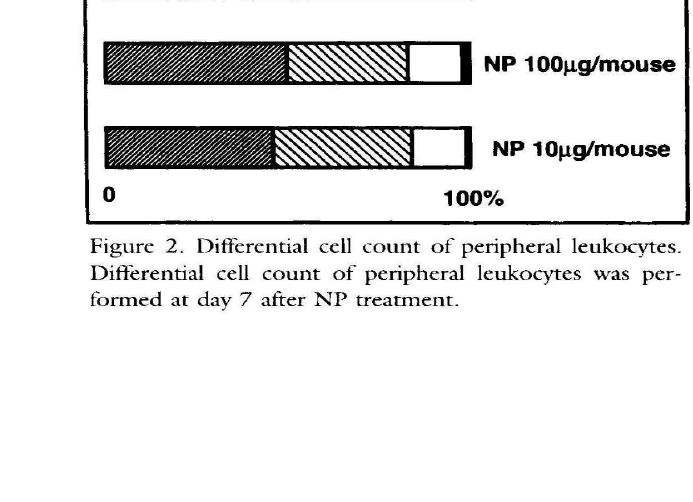
with NP was observed (Figure 3) (absolute num ber of CFU -GM per tibia in control animals were 30744± 3118, 38305± 1732 and 32286± 3371 at days 1, 7 and 14, respectively). Figure 4 shows